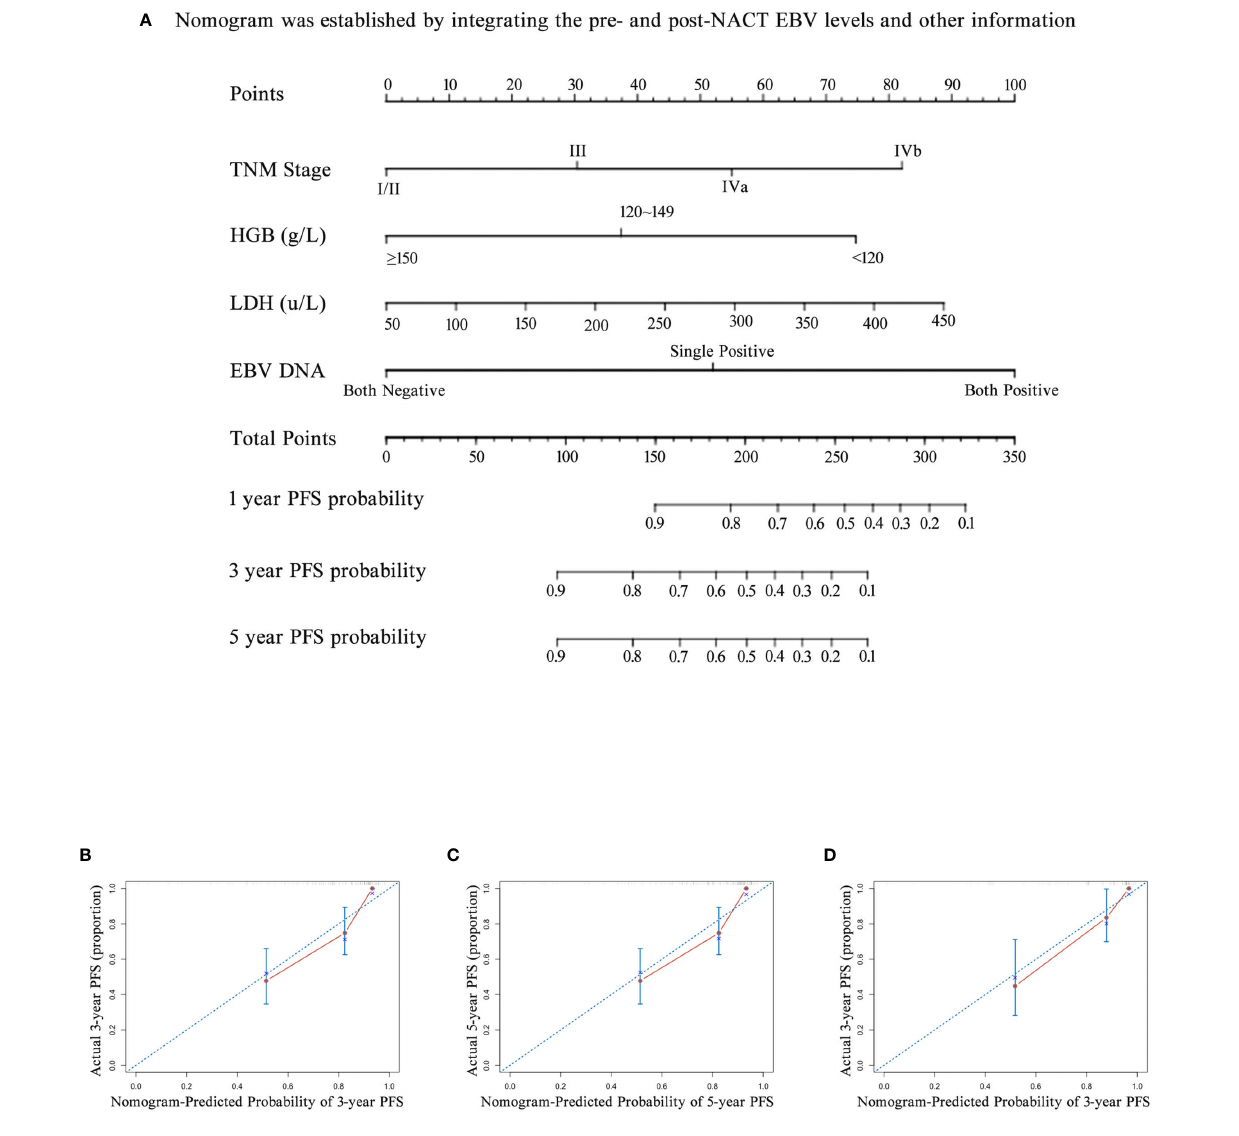
FIGURE 6 | The nomogram and its calibration curve established by using pre- and post- neoadjuvant chemotherapy (NACT) EBV levels. (A) Nomogram; The calibration curves for predicting patient PFS at (B) 3-year and (C) 5-year in the primary cohort and (D) 3-year in the validation cohort. Actual PFS is plotted on the y-axis; nomogram-predicted probability of PFS is plotted on the x-axis. PFS, progression-free survival.